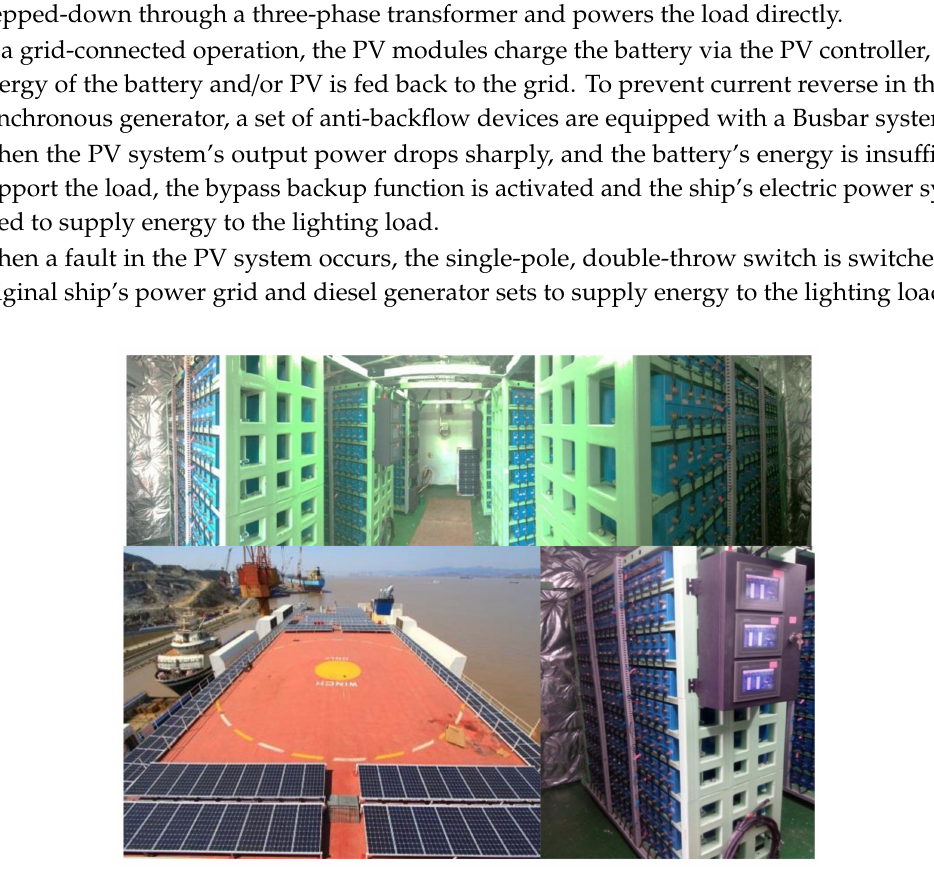
Figure 2. A schematic diagram of the remodeled hybrid electrical energy generation